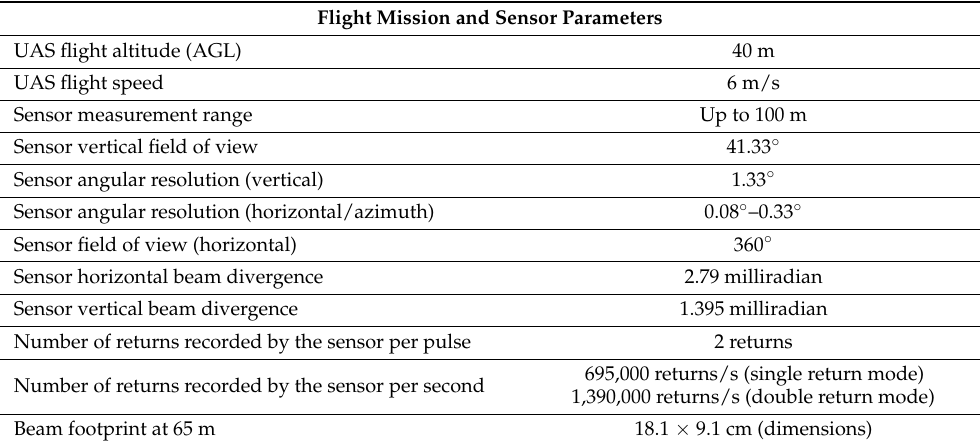
Table 5. Mission and UAS-mounted lidar sensor parameters, courtesy of Velodyne lidar,